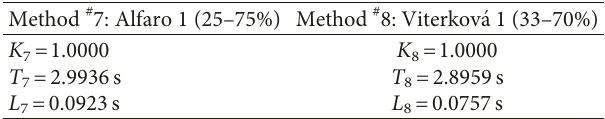
Table 15: FOPDT model parameters obtained using Alfaro’s and Viterkov´a’s two-point methods, respectively.